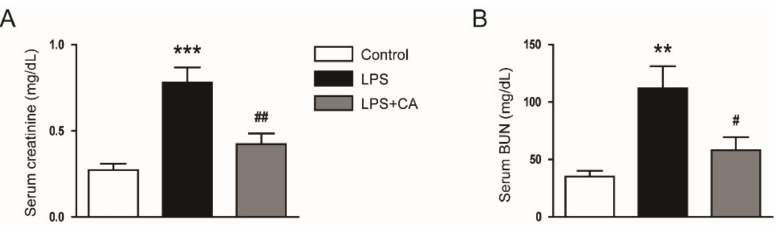
Figure 3. Effect of carnosic acid on serum creatinine and BUN levels. ( A ) Serum creatinine levels. ( B ) Serum BUN levels. n = 8 per group. ** p < 0.01 and *** p < 0.001 versus control. # p < 0.05 and ## p < 0.01 versus